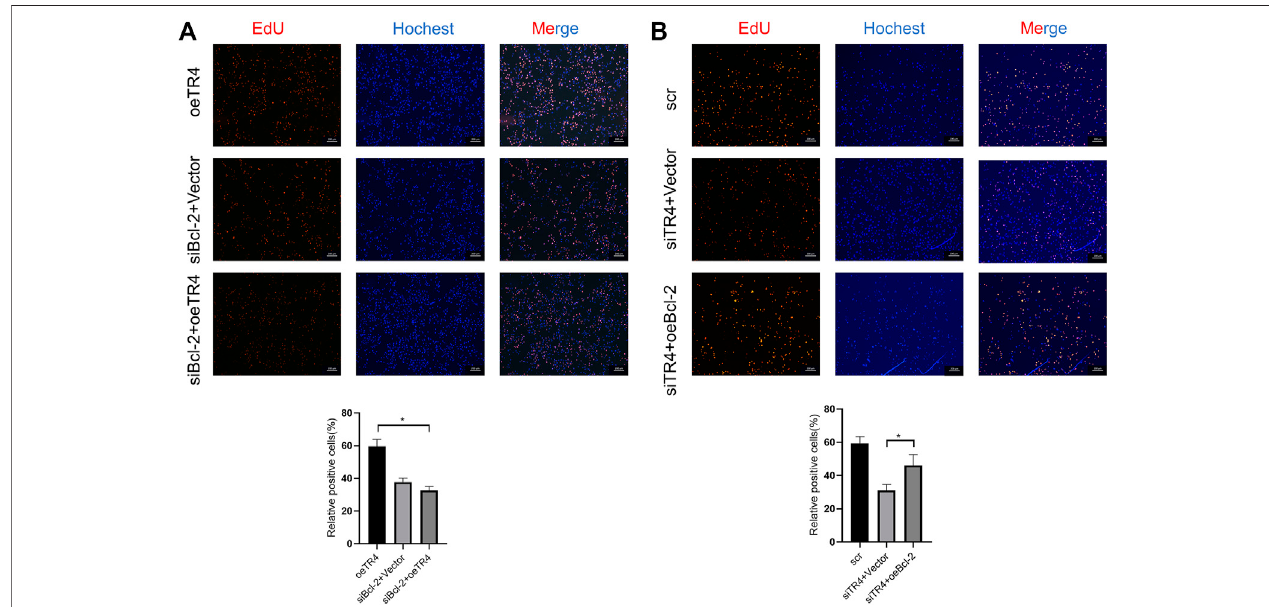
FIGURE6| TheeffectofTR4onviabilityisdependentonBcl-2inT24cells. (A) EdUassaywasusedtoevaluatetheproliferationabilityafterknockingdowntheBcl- 2 expression in oeTR4-T24 cells, * p < 0.05. (B) EdU assay was used to evaluate the proliferation ability after overexpressing Bcl-2 in siTR4-T24 cells, * p < 0.05.